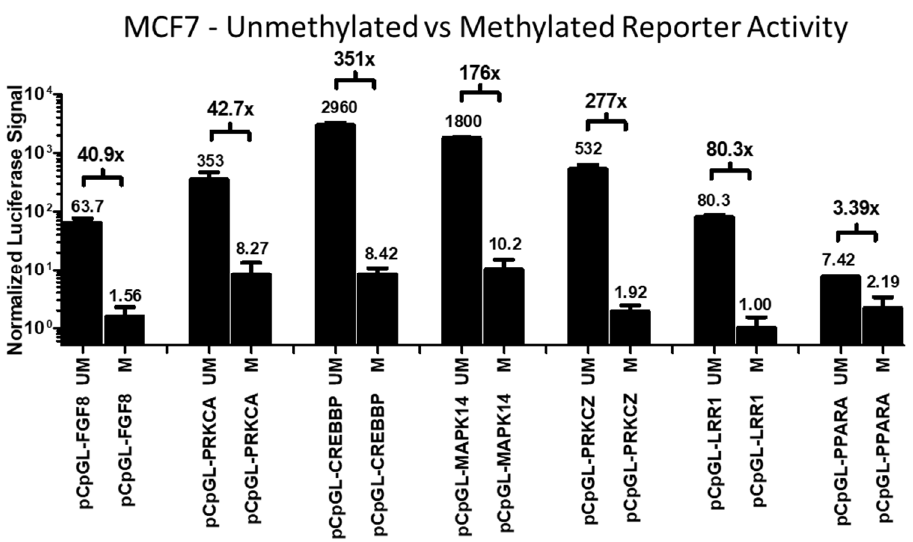
Figure 4. Relative activities of methylated and unmethylated pCpGL reporter constructs in MCF7 cells. Each well (96-well plate) was co-transfected with 100 ng of a methylated or unmethylated pCpGL reporter plasmid construct and 5 ng of pRL-SV40 renilla luciferase internal standard. The firefly luciferase pCpGL reporter signal was normalized to the pRL-SV40 renilla luciferase signal (firefly/renilla) in the same well. In order to emphasize the multi-log range of relative activities between all constructs, both methylated and unmethylated, all values were normalized to methylated pCpGL-LRR1, the condition with the lowest firefly/renilla signal ratio, which was defined as =1 (see values above each bar). The fold difference in signal for each methylated and unmethylated pair is shown. UM: Unmethylated. M: Methylated. Error bars indicate SEM ( n =